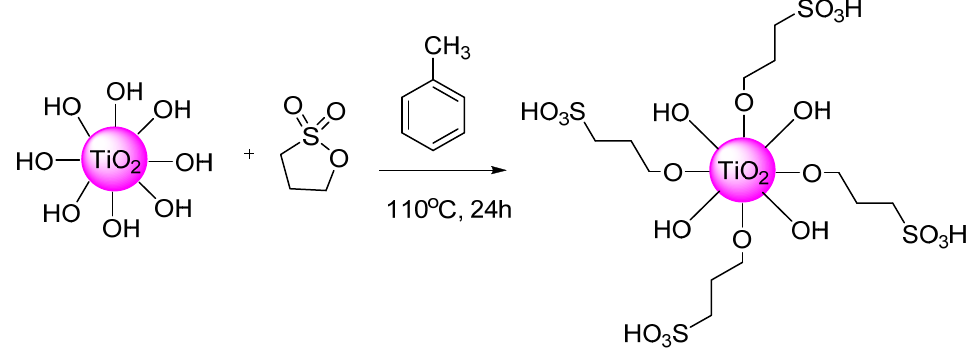
Figure 1. Schematic for the sulfonation of nano-TiO 2 .